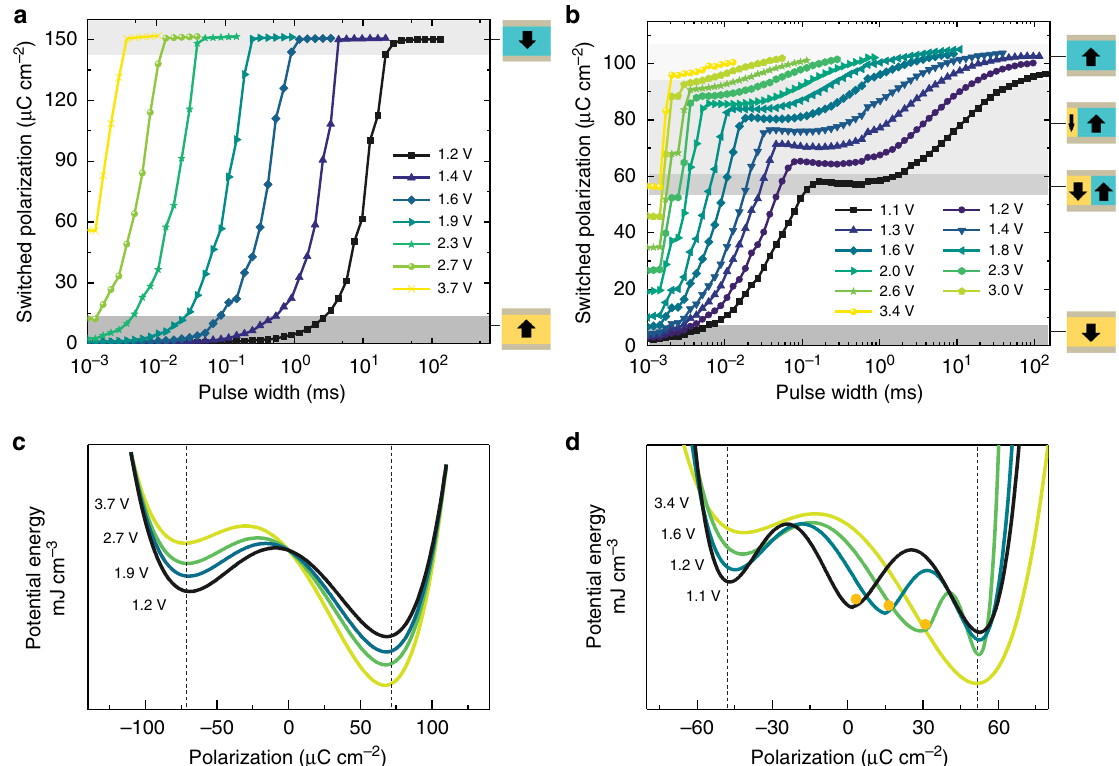
Fig. 2 Pulse-switching measurements. Switched polarization measured as a function of pulse width for different pulse voltages at a pulse delay of 1 ms in ( a ) (001)-oriented heterostructures, which exhibit typical bipolar switching from the down- to up-poled state, and ( b ) (111)-oriented heterostructures, which exhibit multi-state polarization between the 50% and fully-up-poled states with increasing pulse voltages. c The estimated double-well energy landscape in (001)-oriented and ( d ) the triple-well energy landscape in (111)-oriented